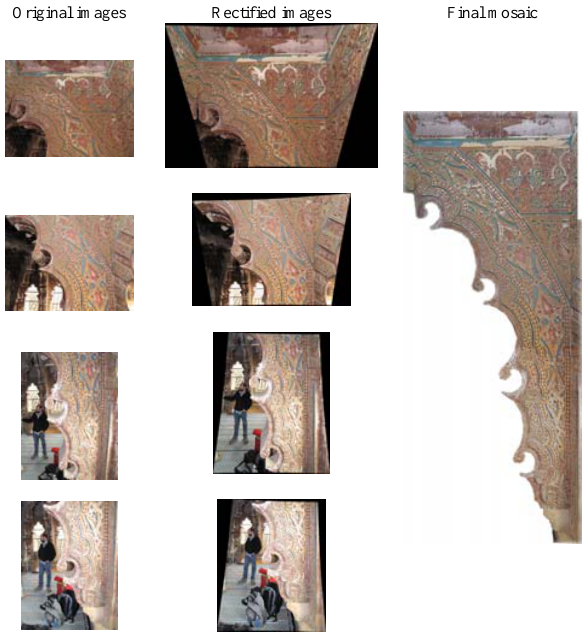
Figure 15. Rectification process in ribs and arches at the